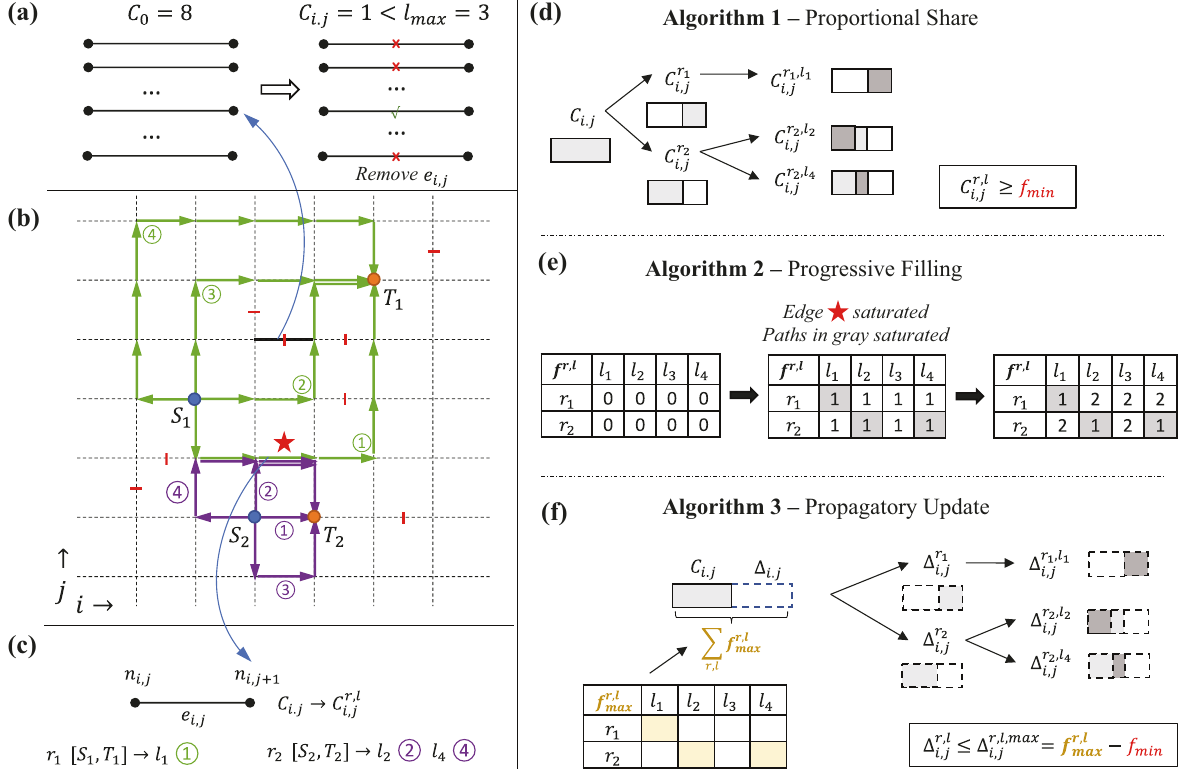
Fig. 3 Illustration of the routing protocol. a Initialization of network topology. On a speci fi c edge, puri fi cation realizes one entanglement pair out of eight available entangled pairs ( C ij = 1, C 0 = 8), which falls below the maximum number of paths l max allowed on each edge. To ensure that each path has at least one channel allocated, this edge with insuf fi cient capacity is then deactivated (indicated by the red bar). b . A sample routing scenario. Two connection requests ( r 1 : S 1 ↔ T 1 ; r 2 : S 2 ↔ T 2 ) are received; four-shortest paths are identi fi ed for each request, utilizing active edges (edges without red bars) on the square lattice network. Each edge may be utilized by multiple paths of a certain connection request, and by multiple requests. Different paths are shown with arrows for clarity, but there is no directionality along the paths. c Capacity allocation scheduling. Three paths for two requests ( l 1 for r 1 ; l 2 , l 4 for r 2 ) utilize the starred edge (in b ), on which the three scheduling algorithms ( d – f ) are illustrated. For proportional share and propagatory update, entangled pairs on this edge are distributed among the three paths through a two-stage allocation: the quota is fi rst determined for each request, then for each path of different requests. In proportional share, the edge capacity is directly allocated; propagatory update calculates the summarized desired capacity on this edge from all paths that utilize it, using the information in the global schedule table, then allocates the unmet capacity demand to these paths. Corresponding deductions are made from the desired fl ows whose sum exceeds the real edge capacity, and the schedule table is updated at each step. The is the desired capacity in the minimum fl ow for each path is f min ; the maximum fl ow deduction for path l of request r is f r ; l (cid:2) f min , where f r ; l max max global routing table. For progressive fi lling, f r , l is 0 on all paths at t = 0 and increases by 1 at each computational interval. At t = 1, the starred edge is saturated and thus the three paths on it are saturated. At t = 2, f r , l keeps increasing on unsaturated